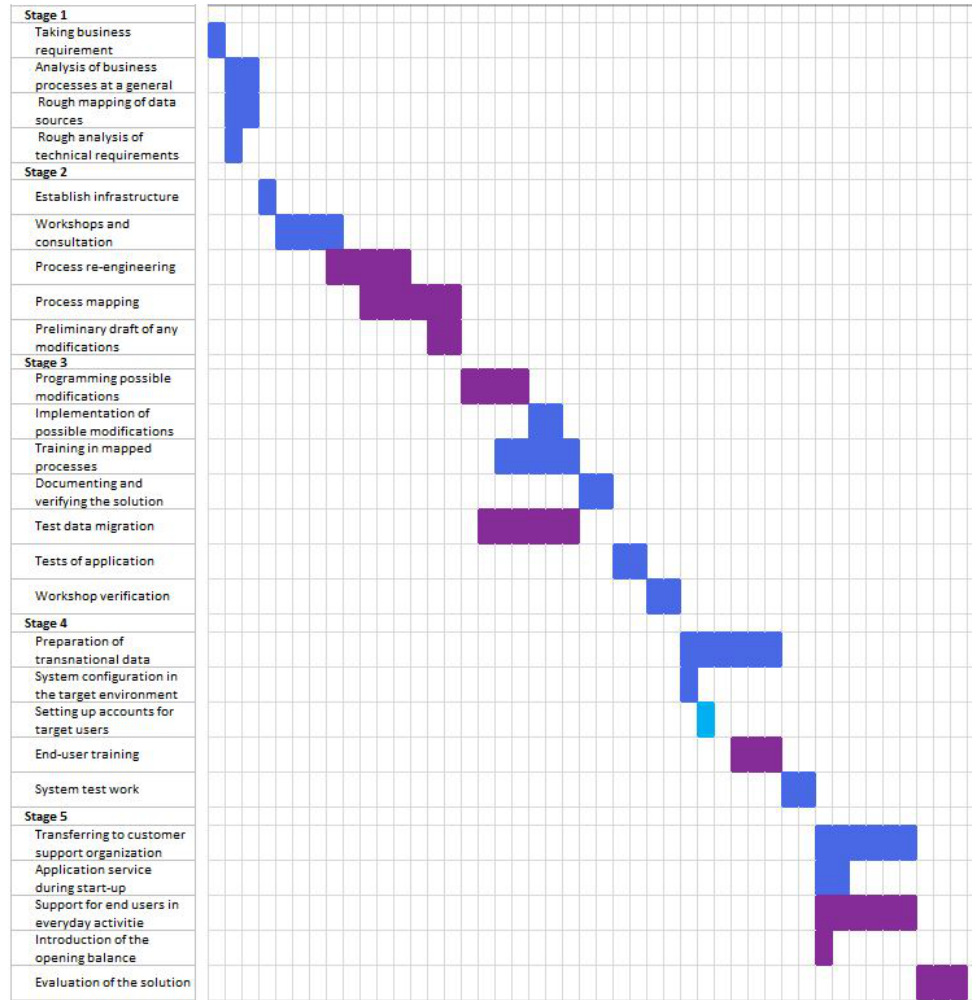
Figure 5. The distribution of work in the classic IFS methodology. High-risk works for the demand fore- casting module are highlighted in purple. Especially in second stage process re-engineering and process mapping task without data analysis are high risk because they may be based on faulty